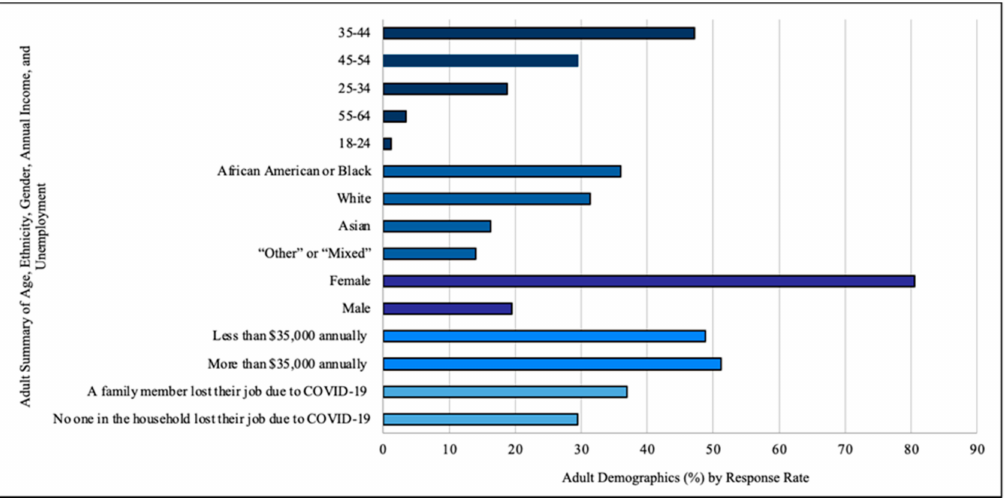
Figure 1. Parent